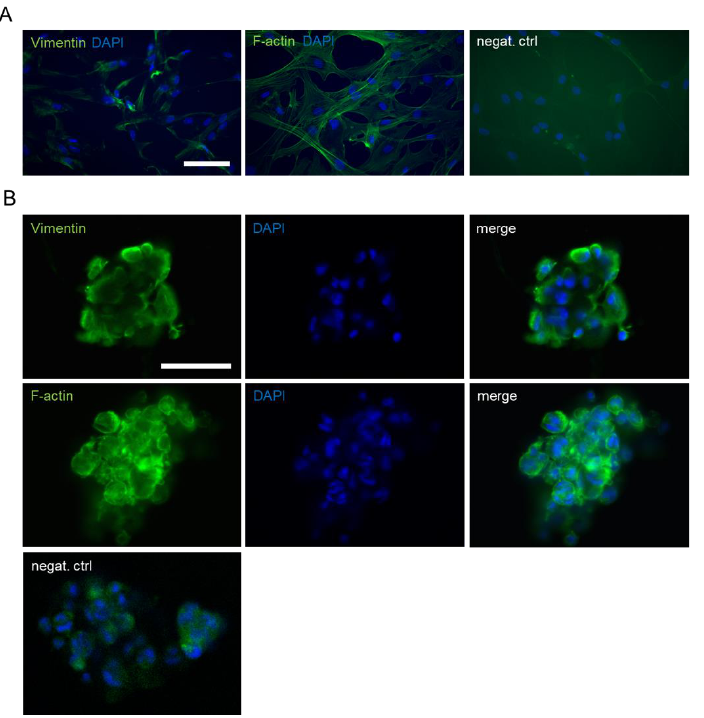
Figure 2. Immunocytochemistry of hASC cultures. ( A ) Expression of Vimentin and filamentous actin (F-actin) in 2D-cultured hASCs. Scale bar, 100 µm. ( B ) Vimentin and F-actin-expressing hASC spheroids cultured in NFC hydrogel with 100 k cell density on d7. Scale bar, 50 µm. Nuclei were stained with DAPI.